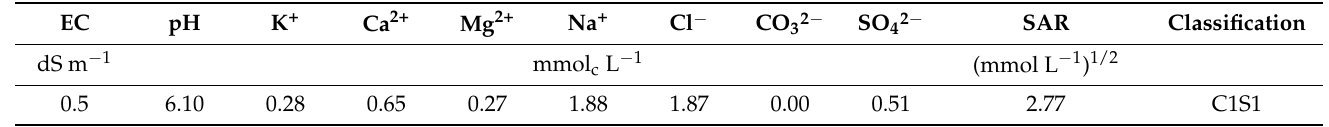
Table 5. Chemical characteristics of surface dam water used for irrigation with low salinity